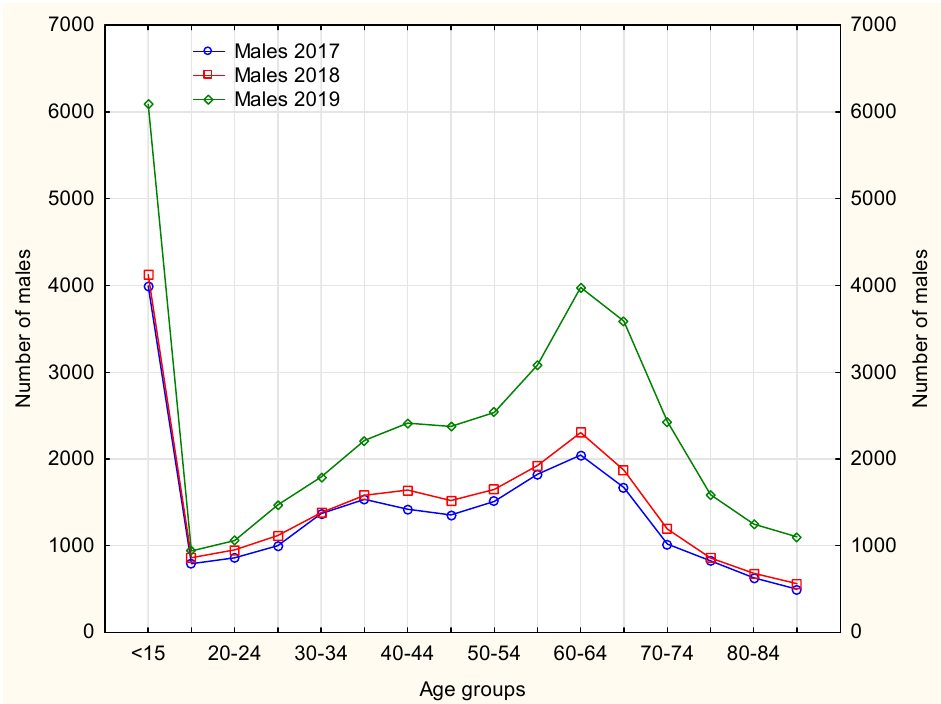
Figure 5. The number of male patients in each analyzed year separately according to age groups.